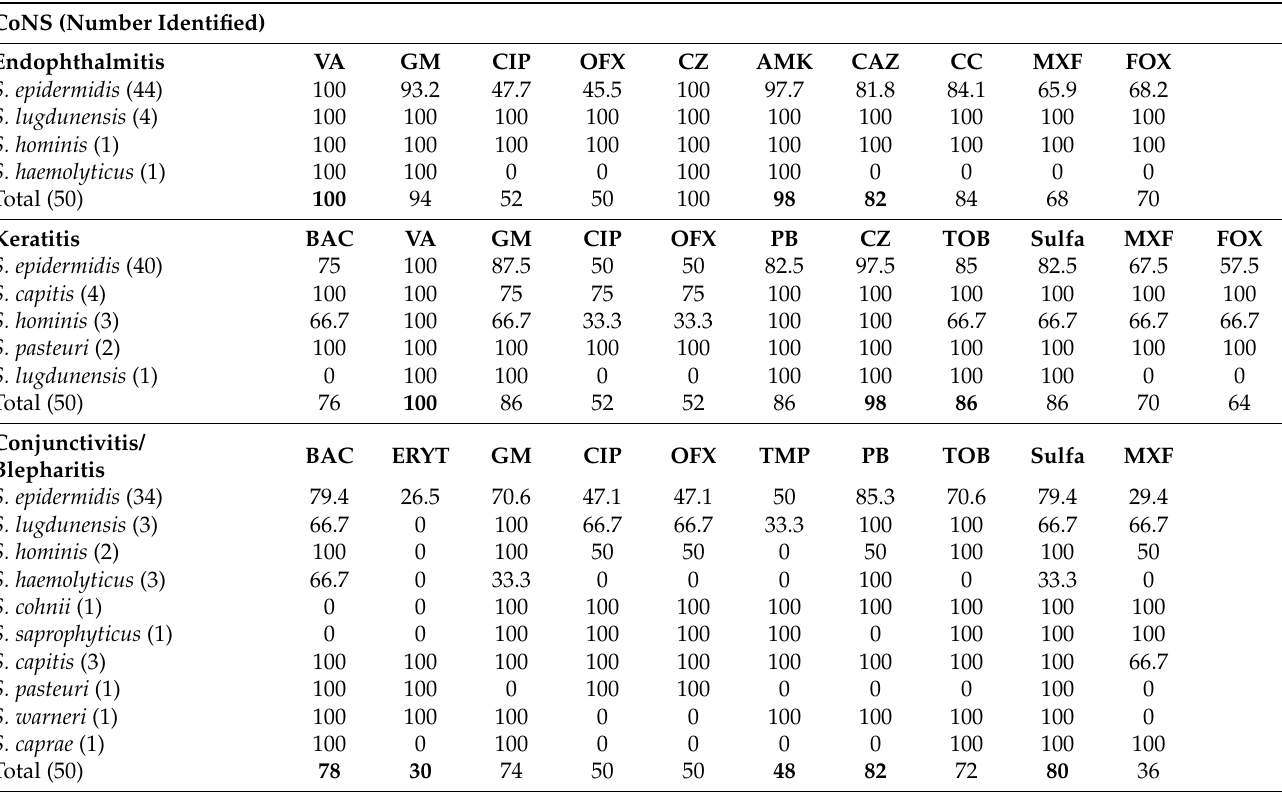
Table 2. Distribution of antibiotic susceptibilities (percent susceptible) for coagulase-negative staphylococci (CoNS). Identification determined by Biolog.